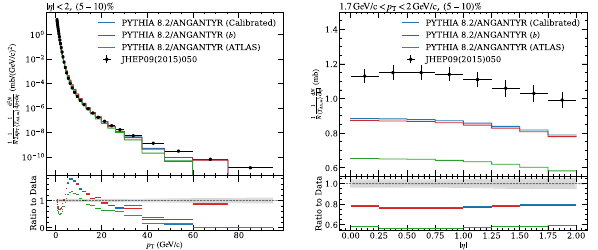
Fig. 10 Charged-particle multiplicity as function of p T (left) and η for 1 . 7GeV / c < p T < 2 . 0GeV / c (right) in Pb–Pb at the 5–10% centrality bin [41], compared to Pythia